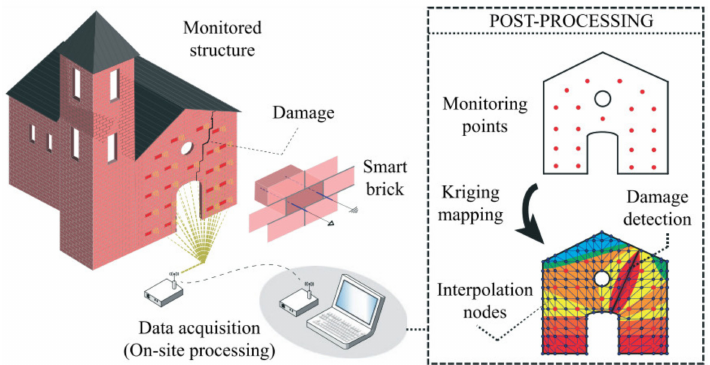
Figure 32. Structural health monitoring system using smart bricks. Reproduced with permission from [97], Garc í a-Mac í as E. et al.,